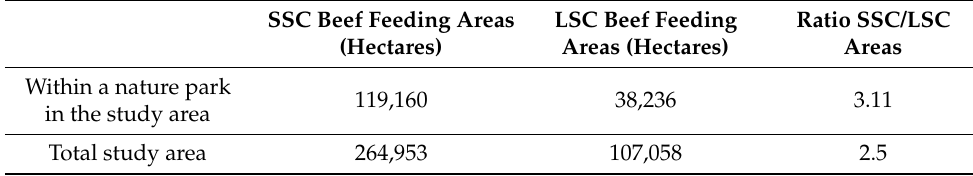
Table 4. Proportion of beef feeding areas in SSC and LSC for areas located within a national or regional nature park of the study